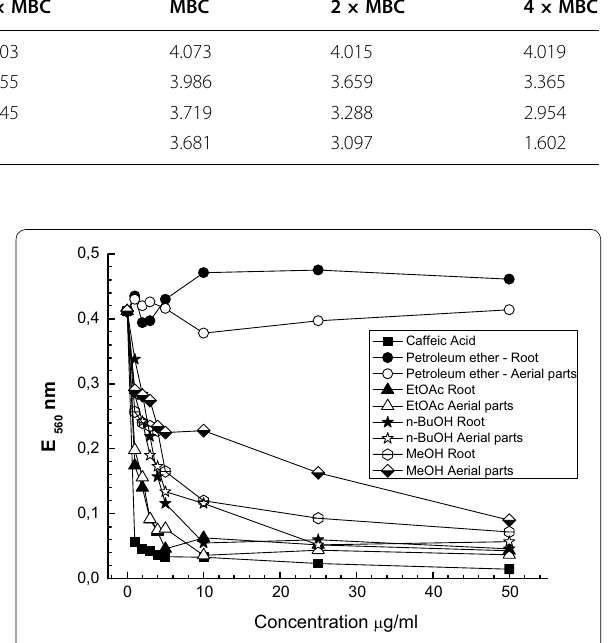
Fig. 4 Dose-dependence of the superoxide anion scavenging effect of the MeOH extracts and fractions from Geum urbanum